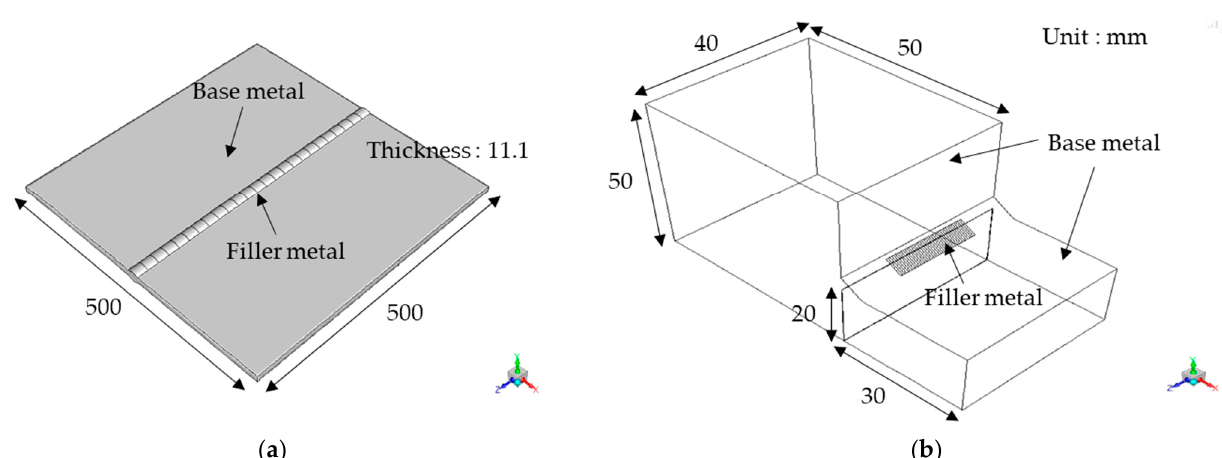
Figure 2. Schematic model geometry for ( a ) SAW and ( b )